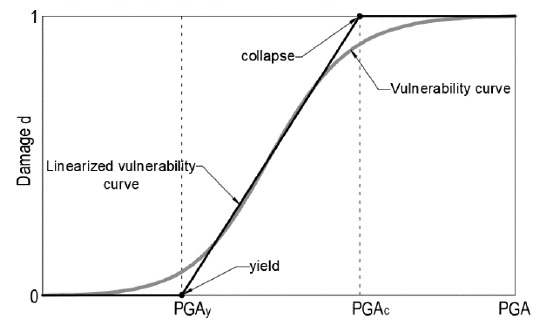
Figure 15. Vulnerability curve and its idealization.